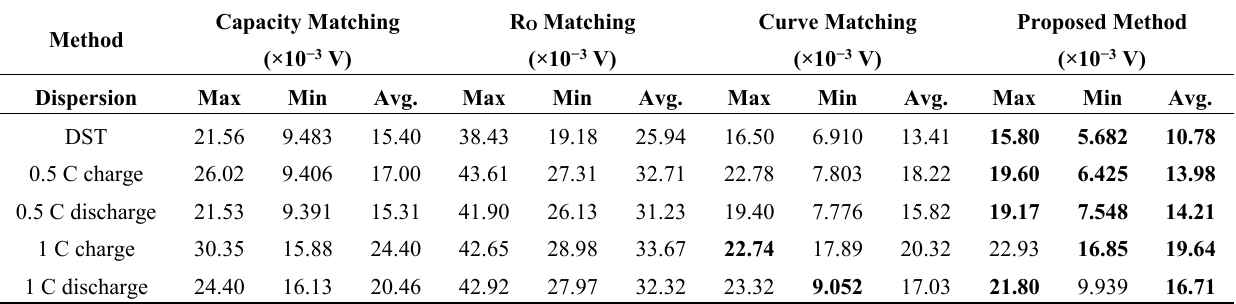
Table 1. Comparison of battery grouping